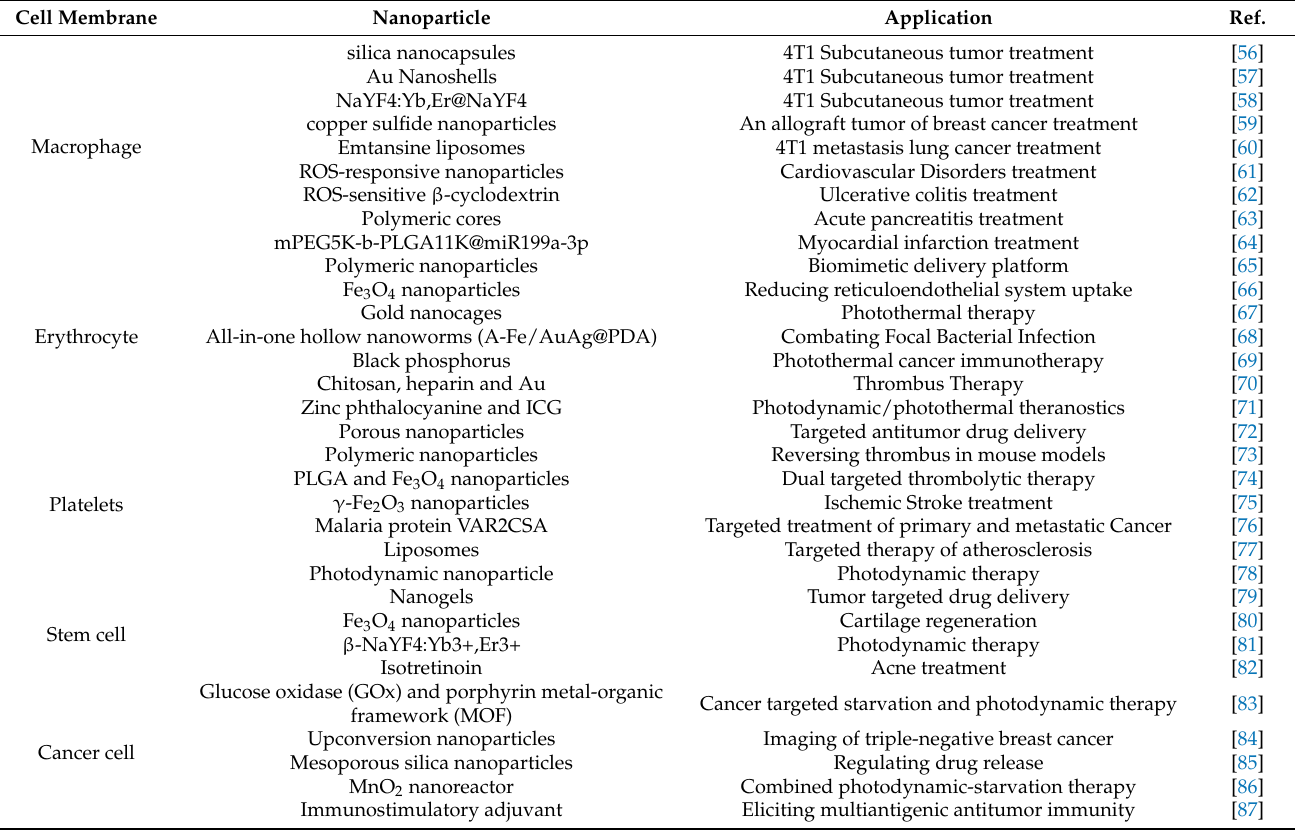
Table 2. Examples of the applications of nanomaterials coated with cell membranes. Cell